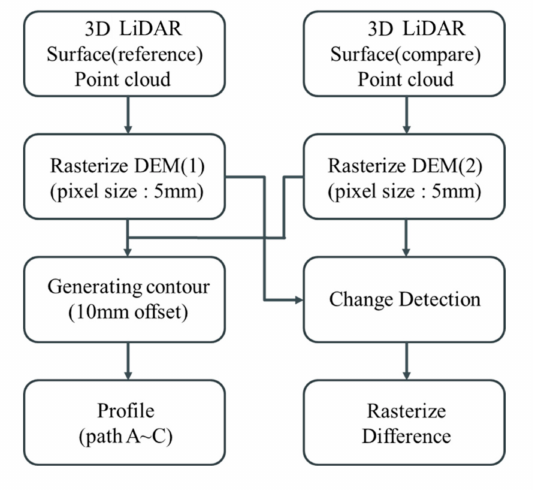
Figure 3. Measurement locations of the wave gauge and flowmeter.